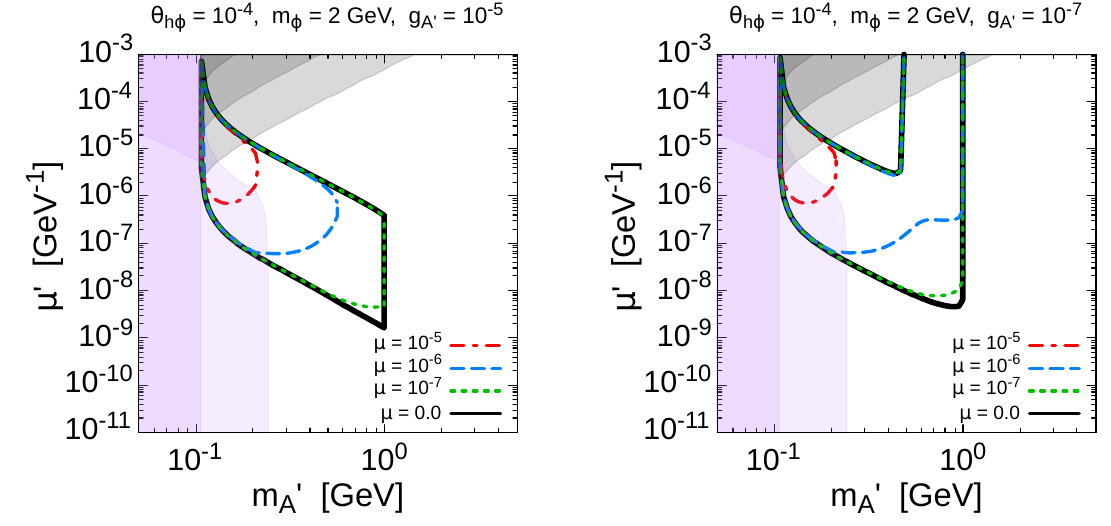
Figure 6 . The contour plots of 95 % C.L. sensitivity regions for the dipole interaction. The gray shaded areas are excluded by µ → eee for µ = 10 − 5 GeV − 1 (light), 10 − 6 GeV − 1 (medium), and 10 − 7 GeV − 1 (dark). The purple shaded areas are excluded by E137 for µ = 10 − 5 GeV − 1 (medium), 10 − 6 GeV − 1 (light), and 10 − 7 GeV − 1